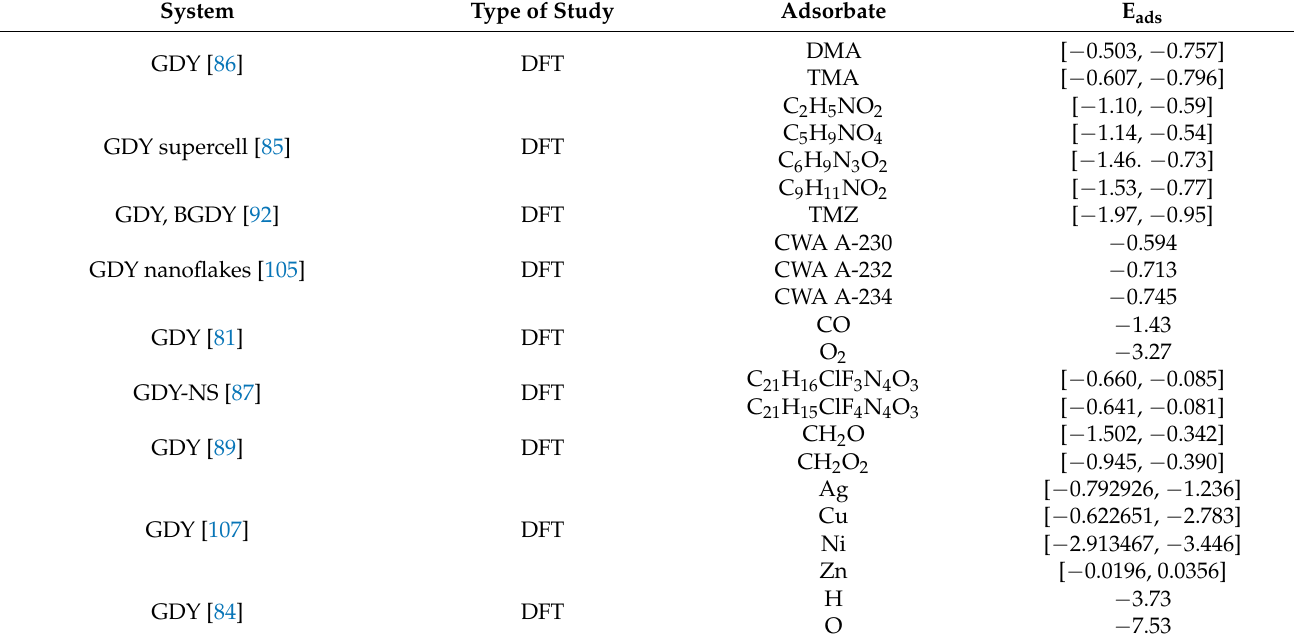
Table 4. Summary of adsorption energies E ads (in eV) for different non-metallic doped graphdiyne systems and adsorbates. The type of study is also